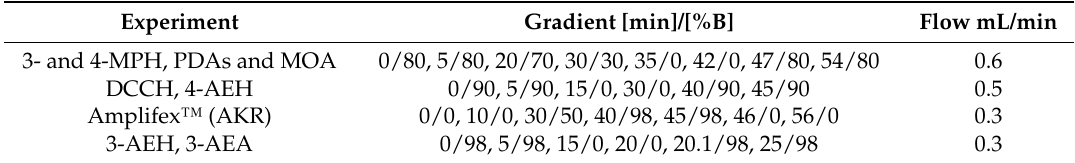
Table 3. Gradients used for HPLC separation of the carbonyl